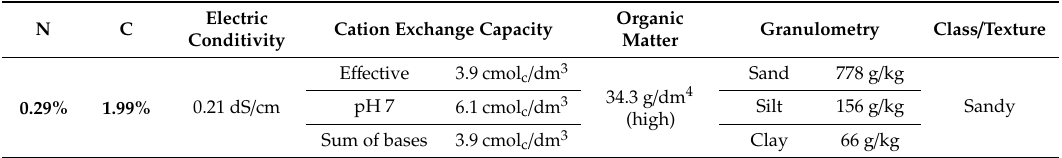
Table 11. Physicochemical characteristics of soil samples